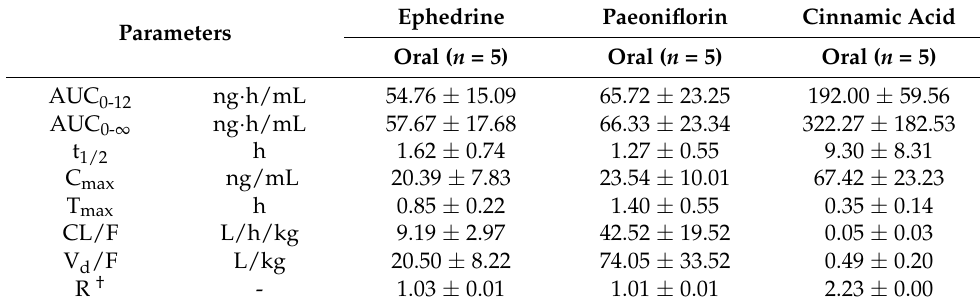
Table 2. Main pharmacokinetic parameters for the three components in rats after a single oral administration of SCRT containing 0.49 mg/kg of ephedrine, 2.475 mg/kg of paeoniflorin, and 0.0125 mg/kg of cinnamic acid. All values are presented as the mean ± standard deviation